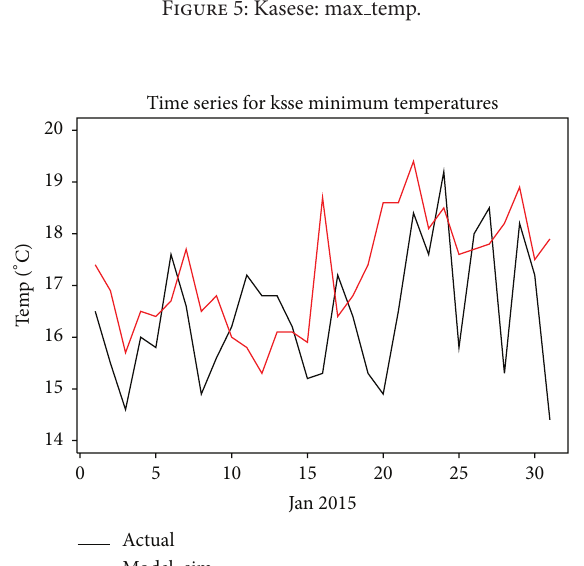
Figure 5: Kasese: max temp.